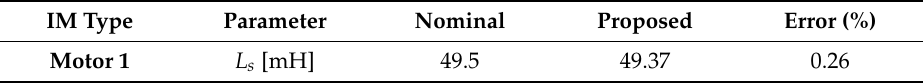
Table 2. Identified Stator Inductance for Motor 1 (Simulation).